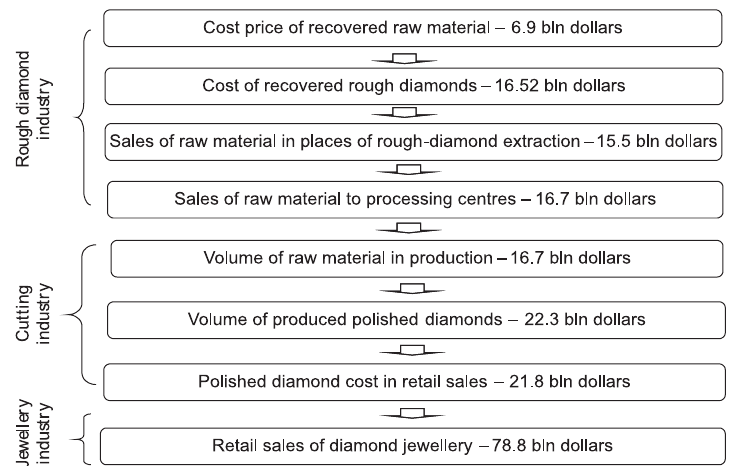
Fig. 1. The diamond pipeline – 2014 (based on Diamond pipeline